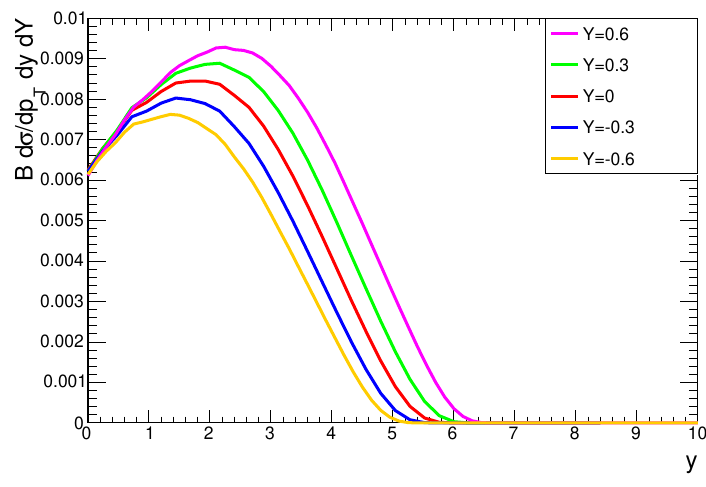
Figure 12 . Distributions of the BFKL evolution length y in J= production in proton-proton collisions by correlated double Pomeron exchange for p S = 13 TeV, p T = 30 GeV and Y = 0 : 6 ; 0 : 3 ; 0 ; 0 : 3 ; 0 : 6. Only the (cid:12)rst term (asymmetric contribution) in eq. (3.3) was included to (cid:0) (cid:0) better illustrate the dependence on the length of the rapidity evolution in the BFKL Pomeron.